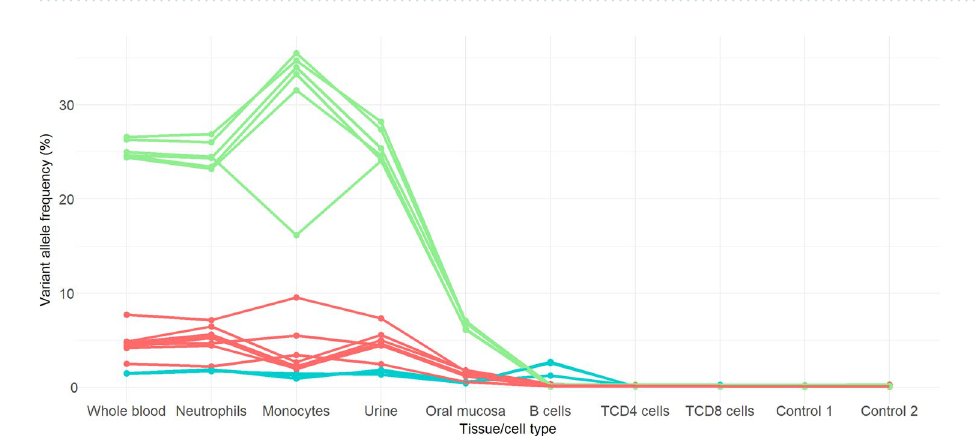
Figure 3. VAF of validated somatic variants in S5 patient per tissue and cell type. Green is used for the group of variants with higher VAF (around 24%), red for those with intermediate VAF (around 4%) and blue for those with low VAF (around 1.5%, the only group present in B cells). Of note, there is one variant in the X chromosome whose frequency has been divided by 2 in order to visualize it grouped with the